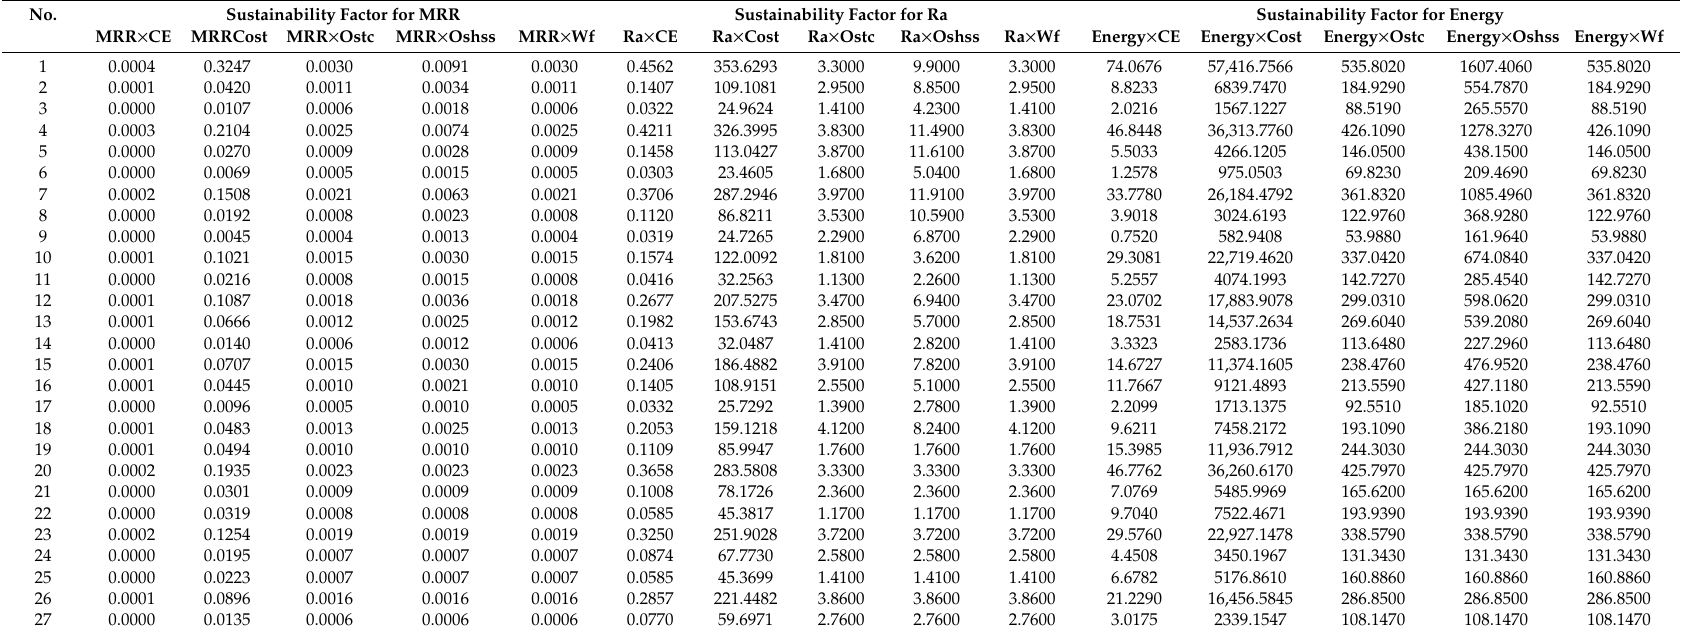
Table A1. OPAI Step 1: Calculation of the sustainability